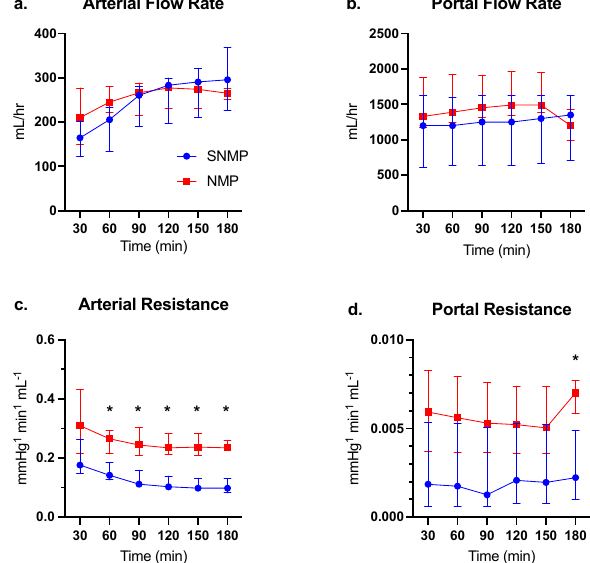
Figure 1. Hemodynamics of discarded human non-steatotic livers during SNMP vs. NMP. ( a ) Arterial Figure 1 . Hemodynamics of discarded human non-steatotic livers during SNMP vs. NMP. (a) Arterial and ( b ) portal flows were similar between groups during three hours of perfusion. Both NMP and SNMP livers demonstrate a steady increase in arterial flow. ( c ) Arterial resistance was significantly higher in the NMP group after the initiation of perfusion. ( d ) Portal resistance tended to be higher in the NMP group but only reached significance after 180 min of perfusion. * indicates p < 0.05 for comparisons using Wilcoxon’s rank-sum test. Abbreviations: SNMP, subnormothermic machine perfusion; NMP, normothermic machine